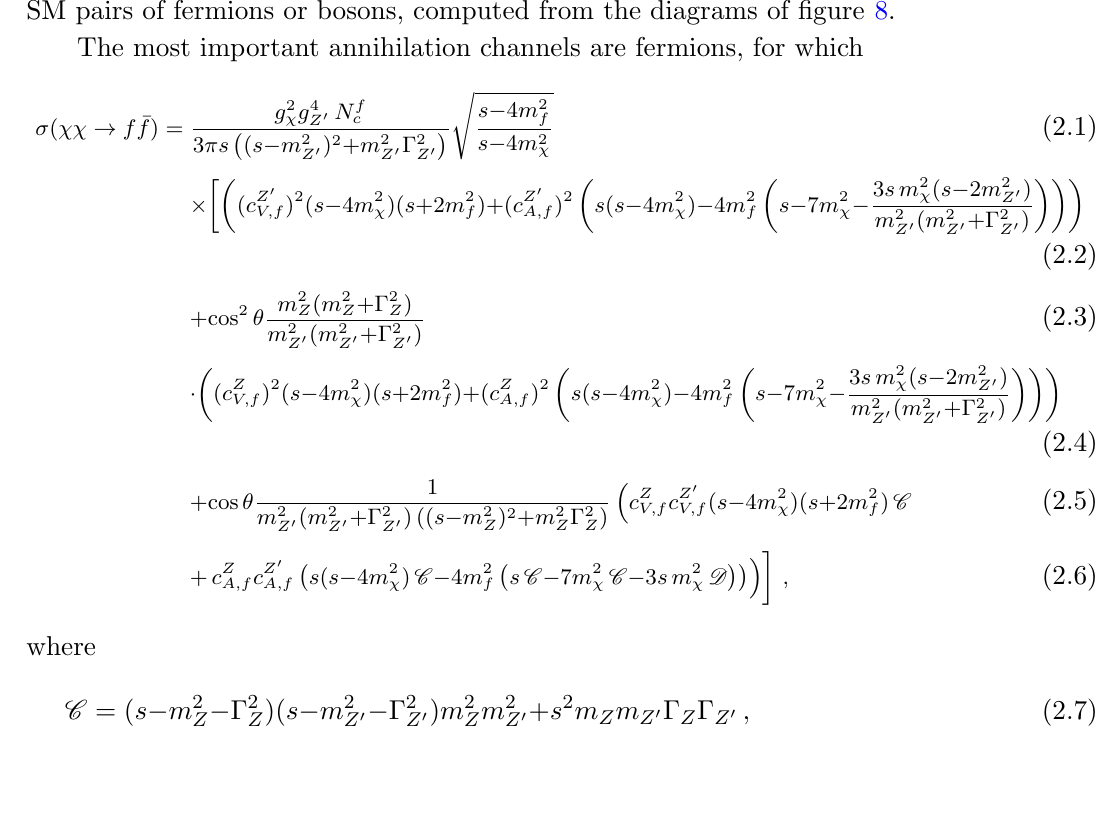
Figure 1 . ( Replaces (cid:12)gure 1 of the original paper .) Contours on the maximal allowed g functions of m Z 0 and (cid:18) for K-factors of 1 and 1 : 3 (to account for non-perturbative QCD